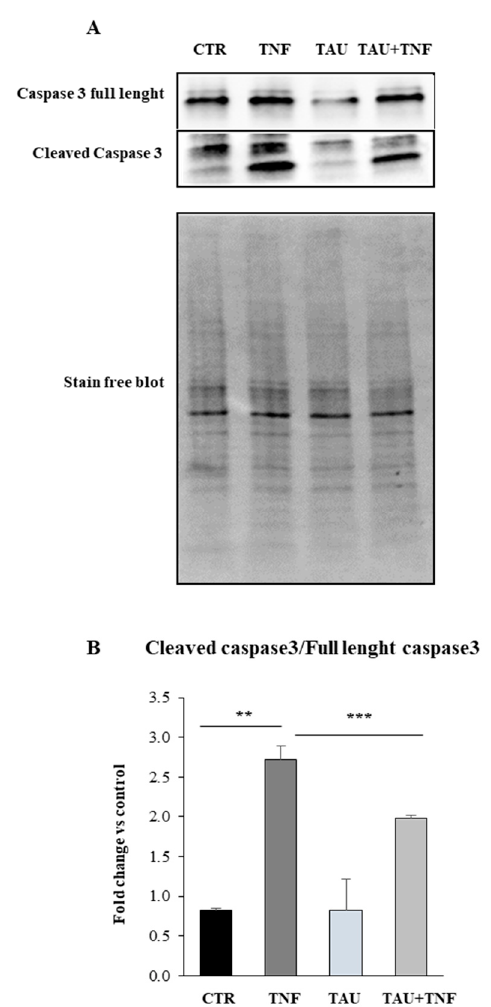
Figure 5. Taurine affects the apoptotic pathway through the modulation of caspase 3 expression. ( A ) Western Blot analysis of caspase full length and the cleaved caspase 3 was achieved in whole extracts of L6 cells after the treatments indicated in the Figure. A representative blot is shown. ( B ) Densitometric analysis performed by using Stain-free blot to verify the loading of the samples. Statistical analysis was performed by Student’s t-test. ** p < 0.01; *** p < 0.01.